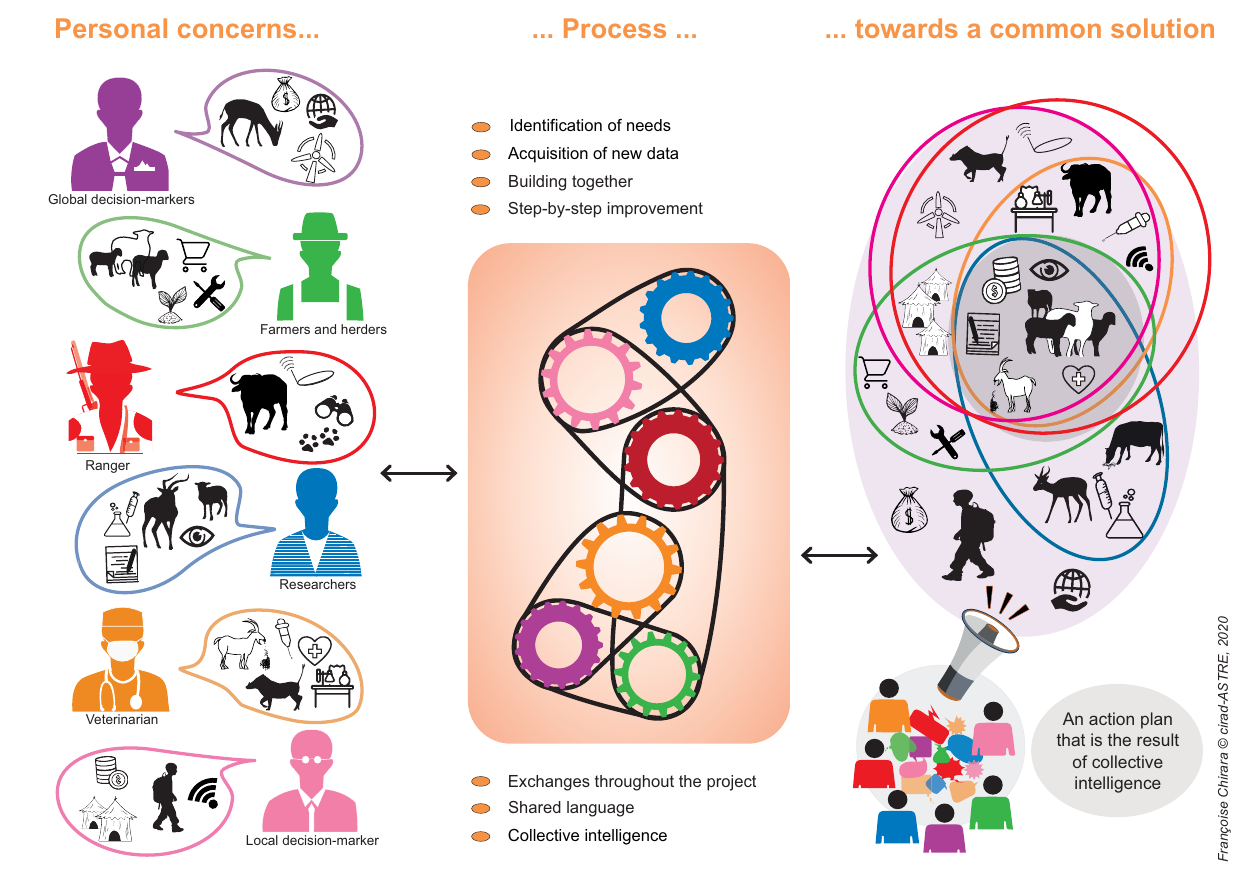
FIGURE 1 | Adapted from (1). Integrated approaches in animal health, CIRAD-ASTRE, Salon International de l’Agriculture , Paris, February 2019. This figure illustrates how an integrated approach to PPR needs to be designed in a given context by key players (farmers, veterinarians, rangers, traders, decision makers, etc.) who together characterize the problems and find solutions to be implemented step by step, taking into account the social and economic context, and environmental changes in addition to the animal health